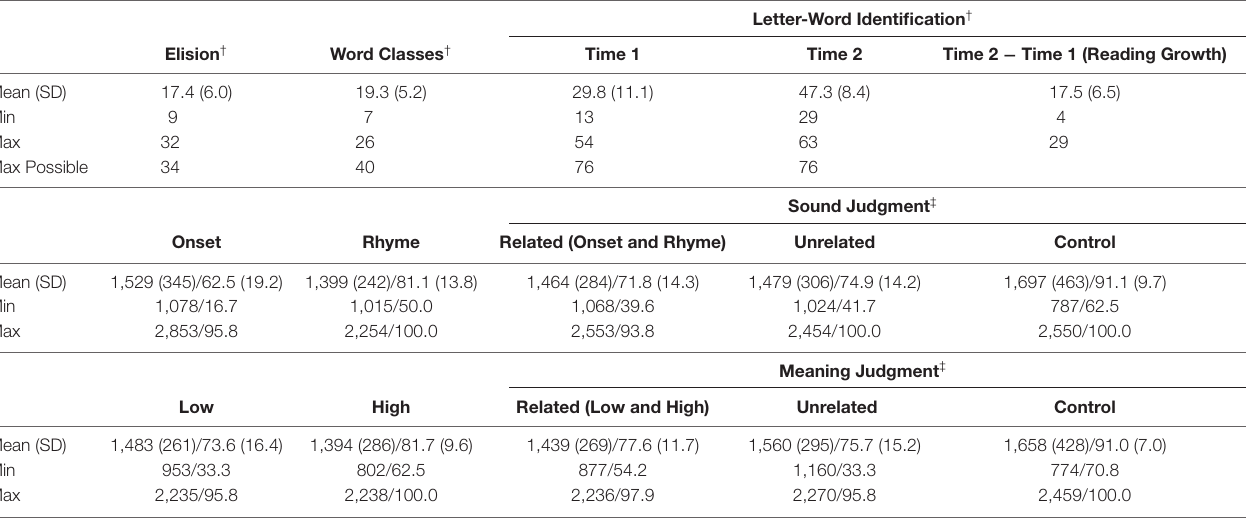
TABLE 1 | Descriptive statistics for the behavioral and fMRI tasks (preregistered